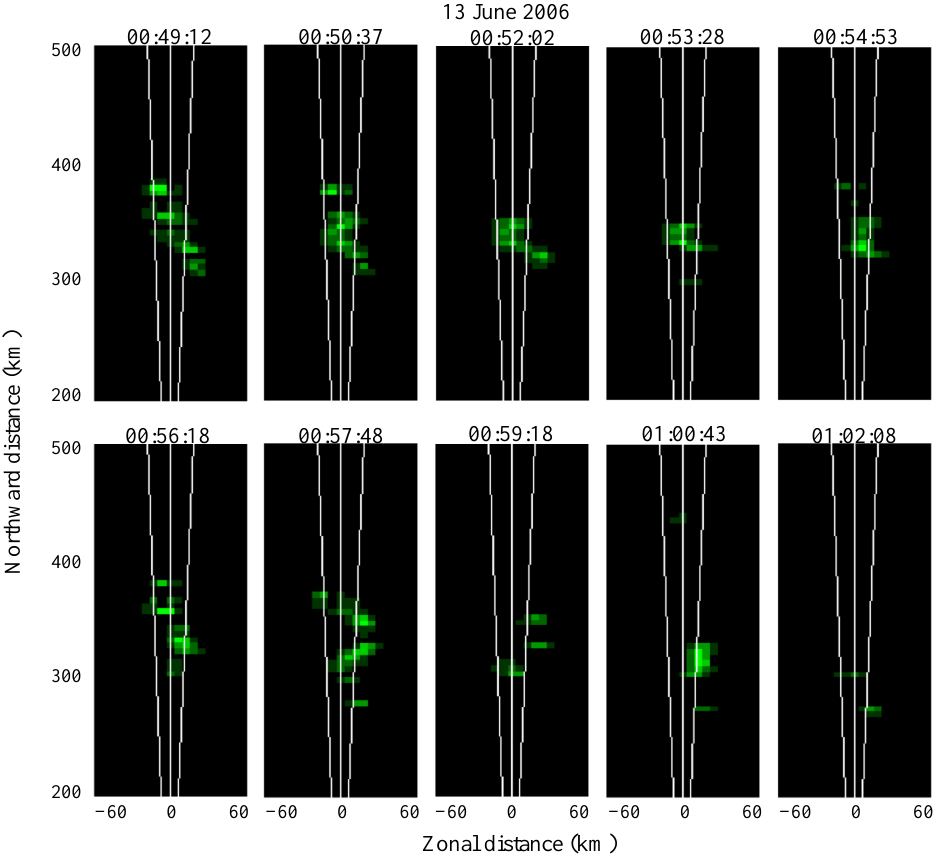
Fig. 7. Same as Fig. 6, except echoes from beam 2 cluster D from 00:49:12 to 01:02:08JST on 13 June 2006 are